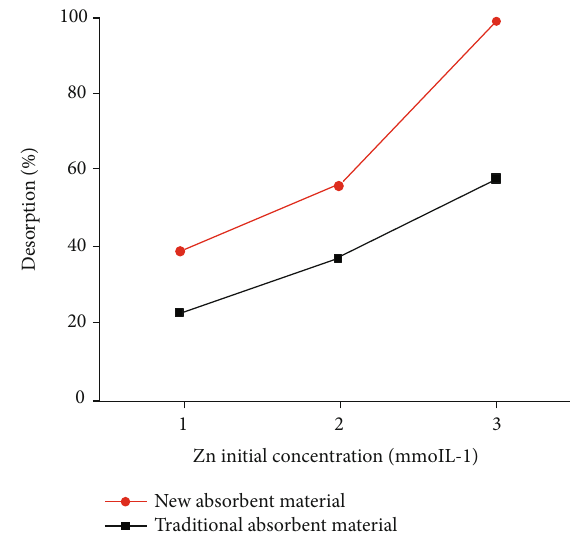
Figure 19: Adsorption of Pb ions by new adsorbent materials and traditional adsorbent